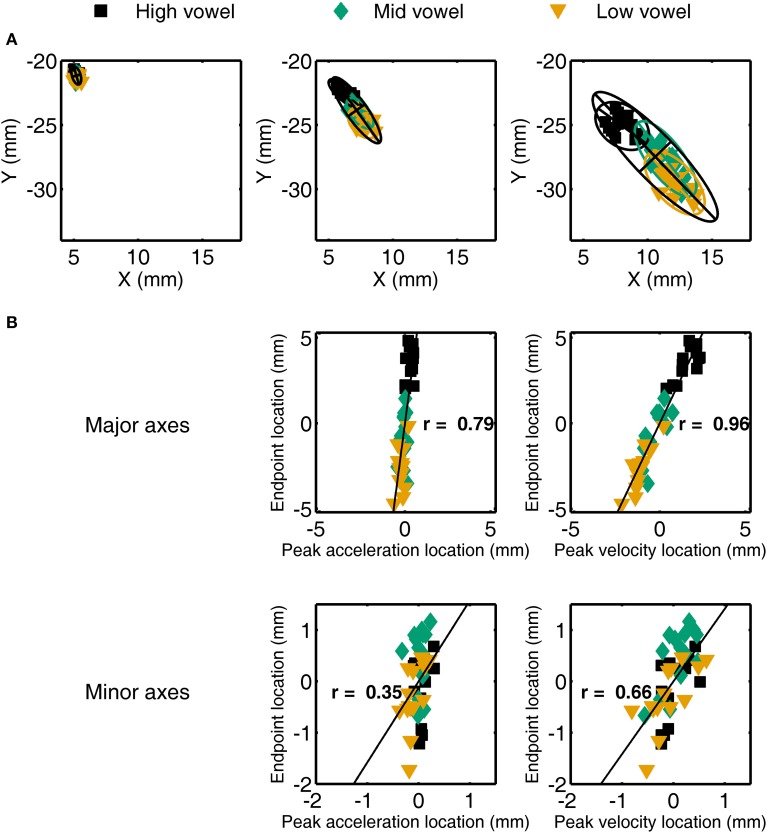
(A) Illustration of jaw spatial coordinates at peak acceleration (left), peak velocity (middle), and movement endpoint (right) for a single subject's /t/ + V syllables. Overlaid ellipses include 95% of the data points with the major and minor axes determined by the first two eigenvectors of the covariance matrix of the (x, y) coordinates. (B) For the same individual subject data, scatter plots and correlation coefficients for the relationship between spatial coordinates at peak acceleration (left) or peak velocity (right) and at movement endpoint after re-expressing those locations relative to the major and minor axes of the ellipses shown in (A). Data expressed relative to the ellipse's major axis are in the upper row, data expressed to the minor axis are in the bottom row.